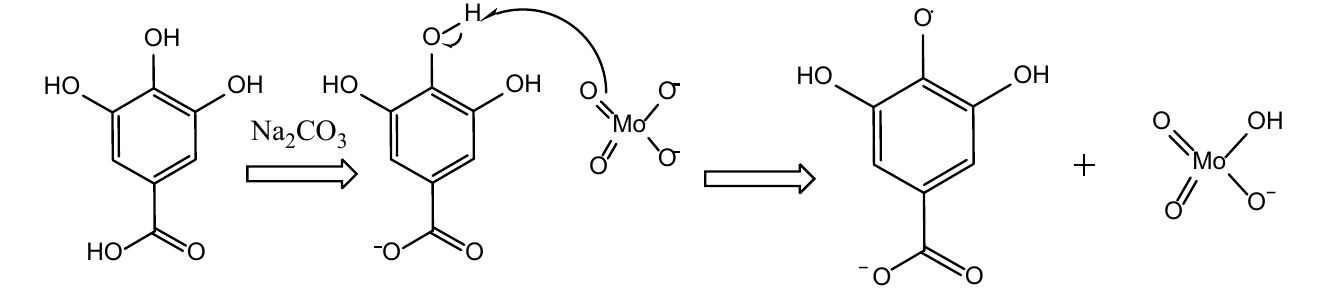
Figure 9. Folin reagent transformation mechanism with gallic acid